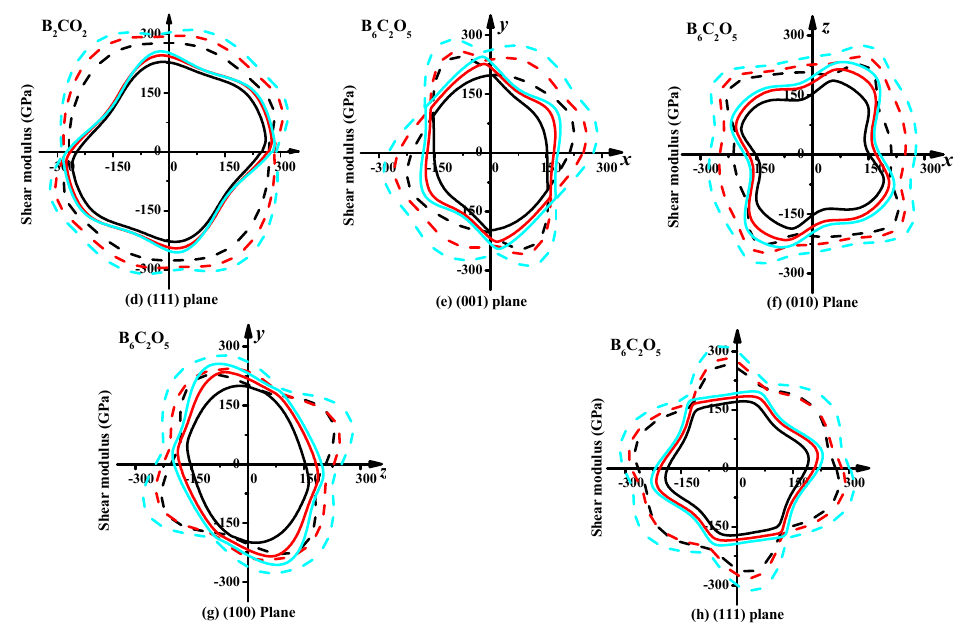
Figure 6. Planar projections of the directional dependence of the shear modulus in B 2 CO 2 , ( a ): (001) plane, ( b ): (010) plane, ( c ): (100) plane, and ( d ): (111) plane; and Planar projections of the directional dependence of the shear modulus in B 6 C 2 O 5 , ( e ): (001) plane, ( f ): (010) plane, ( g ): (100) plane, and ( h ): (111) plane.